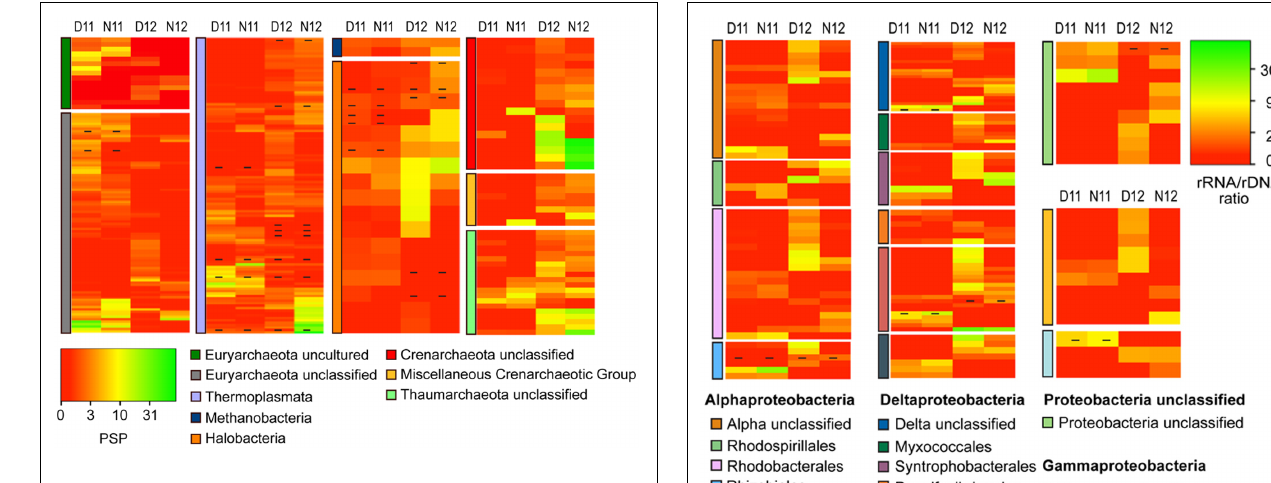
expression was below detection under both salinities.